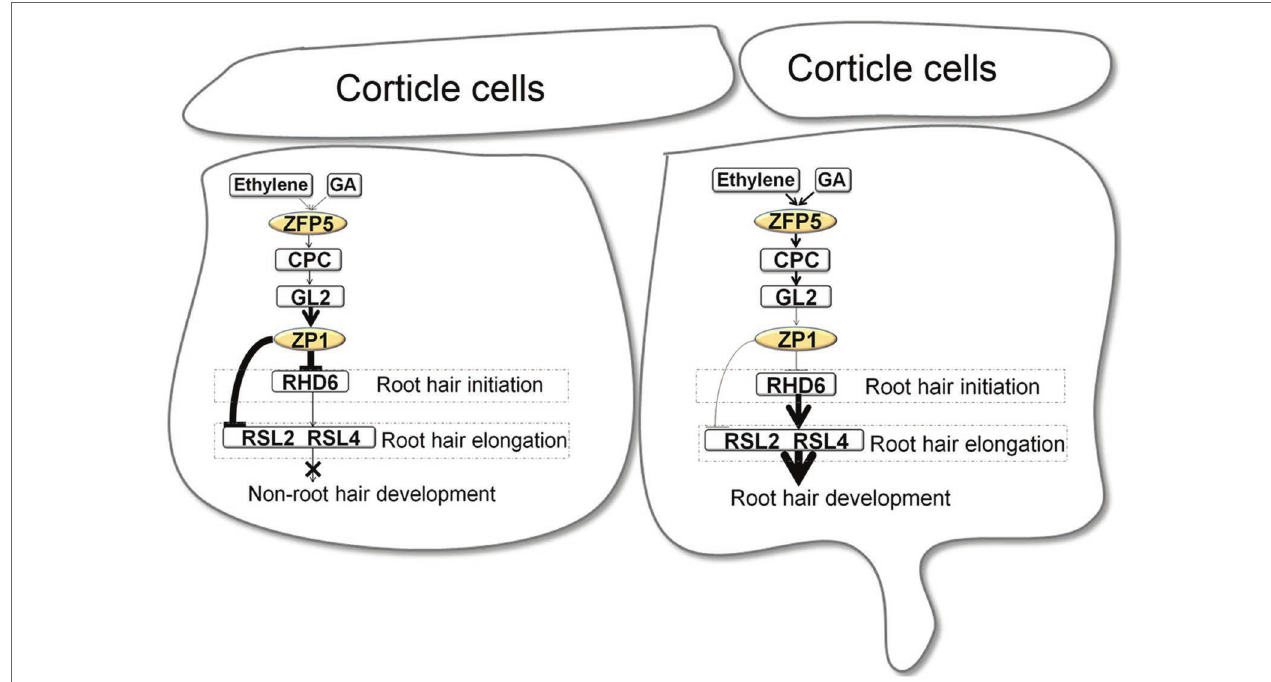
FIGURE 2 | Root hair development regulatory network involving the C2H2 zinc finger proteins in Arabidopsis (An et al., 2012; Han et al.,